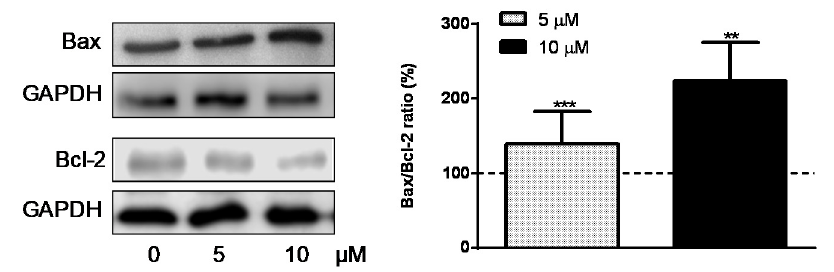
Figure 7. Western blot analysis of Bax and Bcl-2 expression in HepG2 cells incubated with R2-viniferin (5 and 10 µ M). The bar graph shows the Bax / Bcl2 ratio, calculated by densitometric analysis of the anti-apoptotic proteins expressed as the percentage of the ratio (molecule of interest / GAPDH protein) detected in the control. Results are the mean + SE of n = 6 experiments. ** p < 0.01, *** p < 0.001, compared with control.